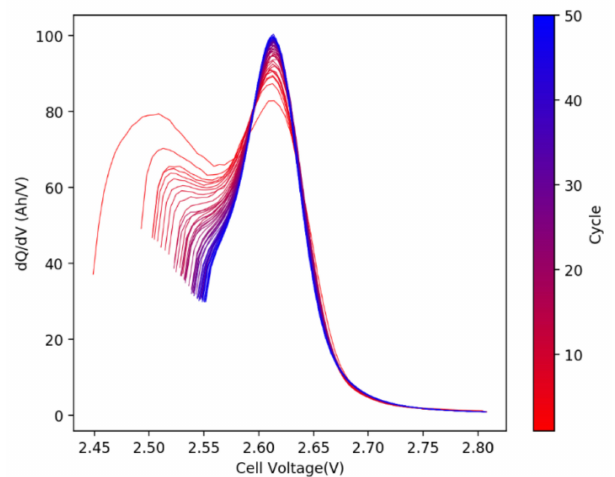
Figure 9. The IC curves of cell #1 during aging cycles.